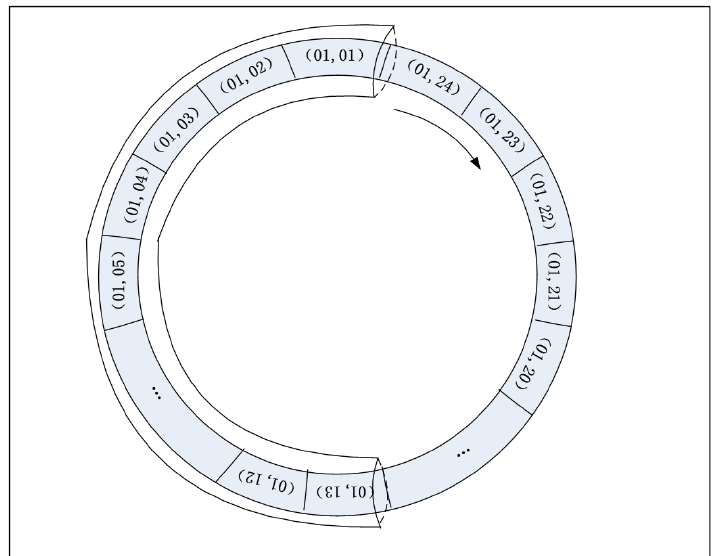
Figure 4. Satellite lighting schematic. In order to introduce the energy balance into the optimization objective, an energy prediction model is necessary. According to “Light Time” analysis, 13 adjacent satellites are in the “day side” for any orbit. A satellite remains in the fuzzy duration and the charging state is ignored. A tubular sliding time window model (TSTW) can imply this property, as shown in Figure 5. In this model, a ring represents 24 satellites in an orbit, and a tubular sliding window represents the light duration. All satellites in the “day side” are surrounded by tubes. The tube will rotate clockwise. By rotating at a specific angle, the illuminating state of the satellite can be predicted.